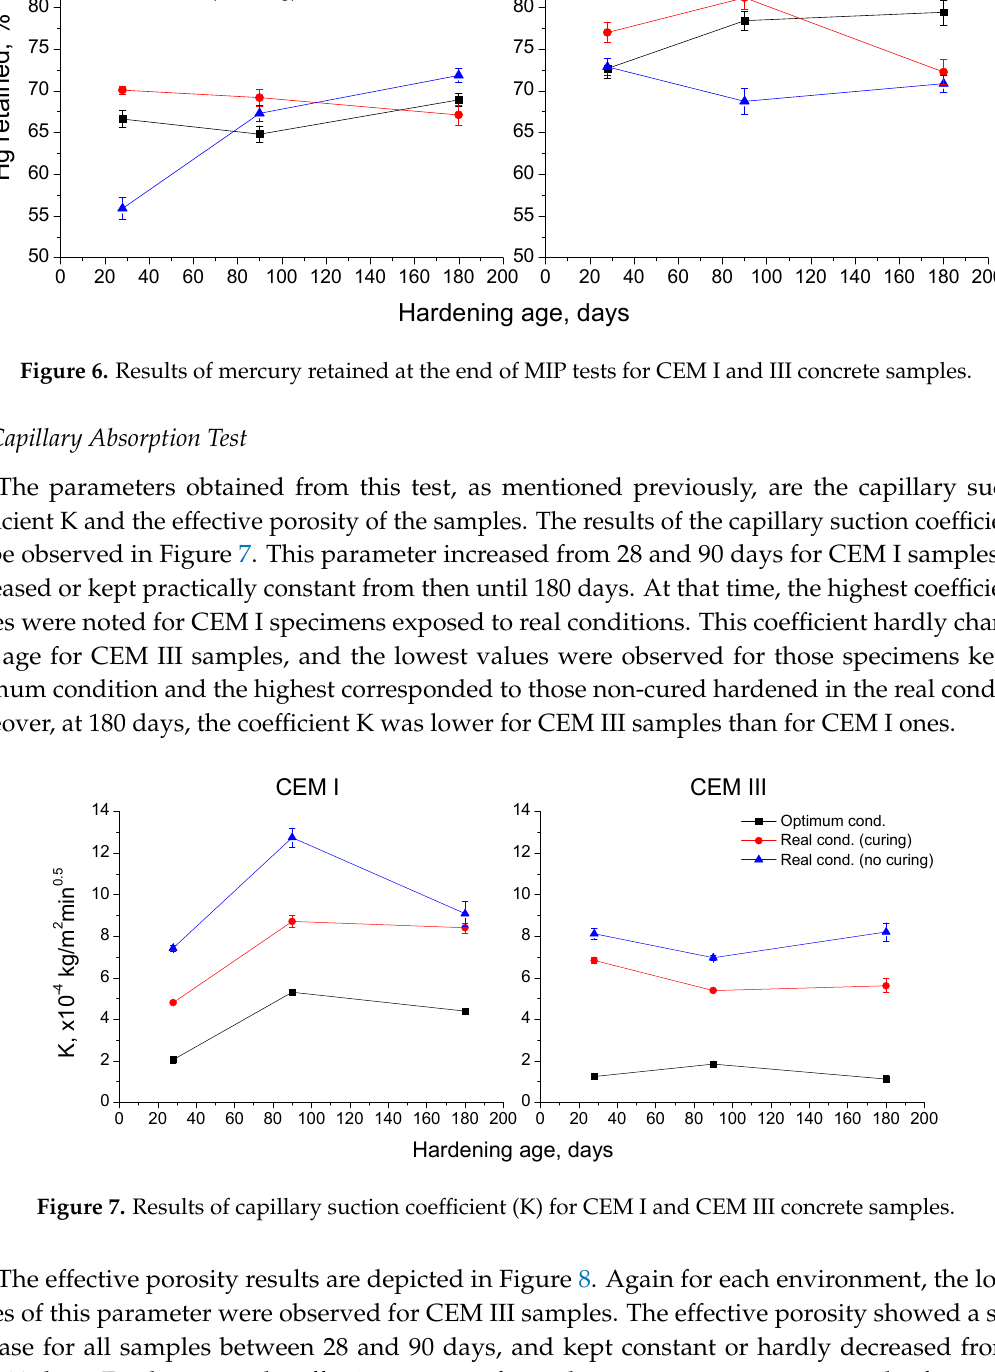
Figure 7. Results of capillary suction coefficient (K) for CEM I and CEM III concrete samples.